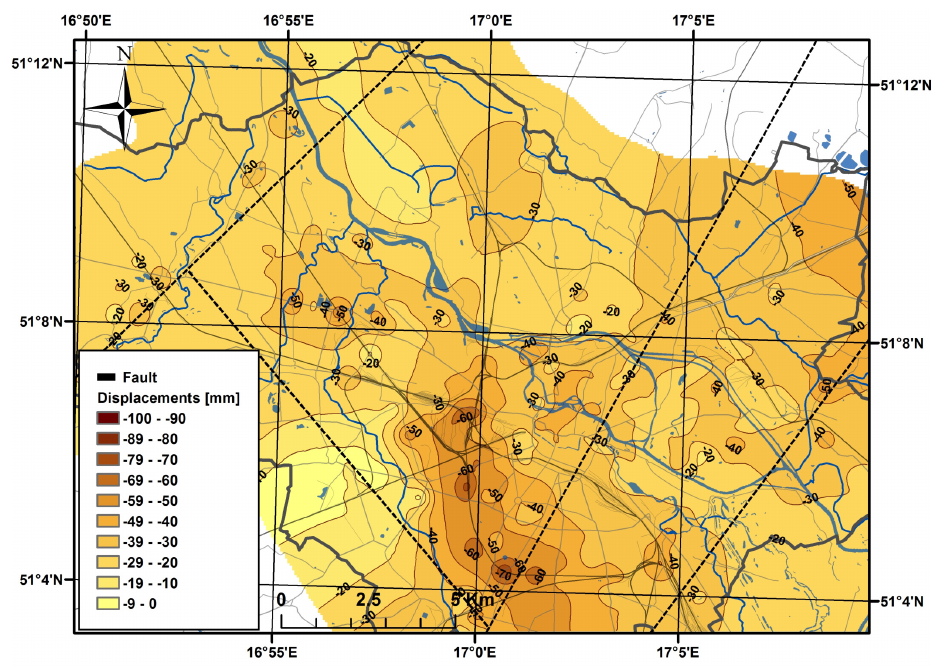
Figure 4. Relative vertical displacements in the 1968–1998 period